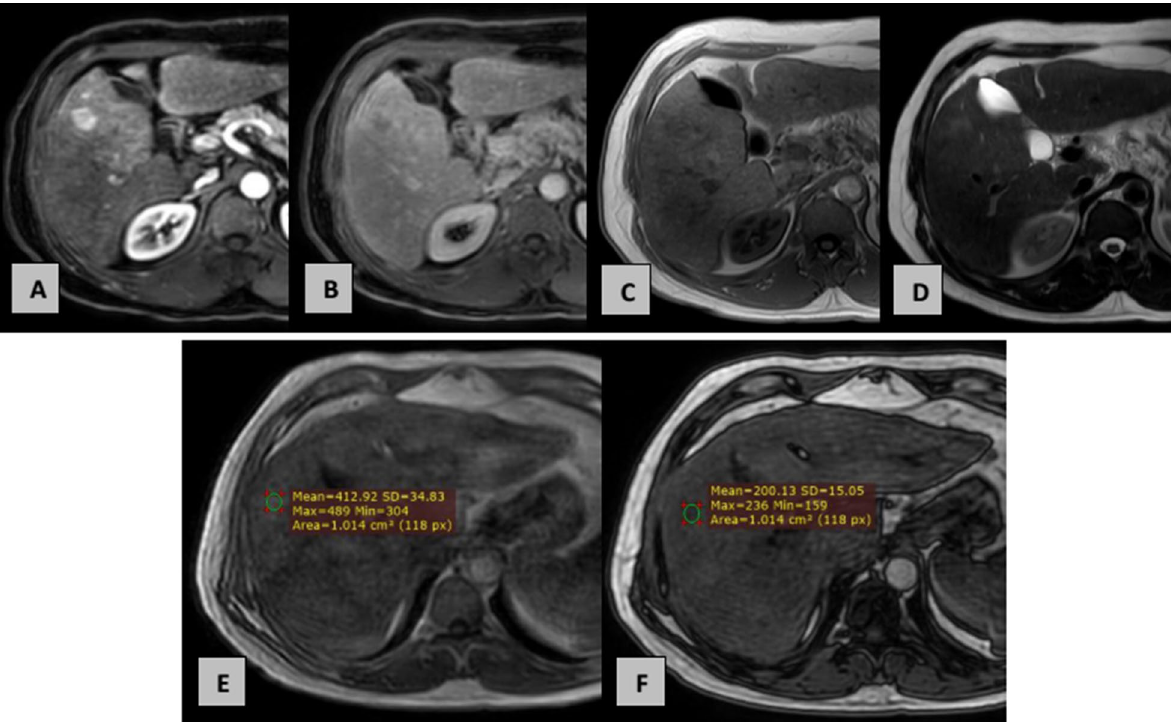
Fig. 5 A 54-year-old male patient with mild cirrhosis and single HCC at segment V. A Late arterial phase, B delayed phase, C T1 WI, D T2 WI, E in-phase gradient echo, F opposed phase gradient echo. The lesion elicits low T1 and mild high T2 signals and shows non-rim APHE and non-peripheral contrast washout. Hepatic fat fraction: 25.7% (moderate steatosis). Major HCC features: non-rim APHE (late), non-peripheral “washout” (late) and size 2 2.2 cm. Ancillary HCC features favoring malignancy: mild T2 hyperintensity. Ancillary features favoring HCC in = × particular: non-enhancing capsule. The hepatic fat fraction in this case was measured at segment V instead of segment VII to avoid the areas